Question: Produce a descriptive caption suitable for publication.
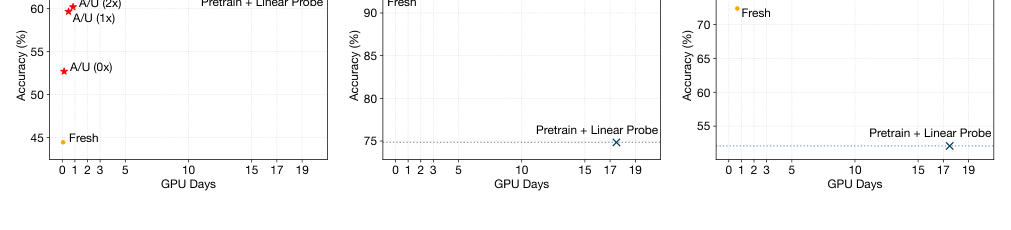
Answer: Cost/accuracy comparison of our method (A/U) to supervised training (Fresh) and pre- training then linear probing. The teacher was a ResNet50 and the student was a MobileNetV2. All timing experiments were done on one NVIDIA P100 GPU.